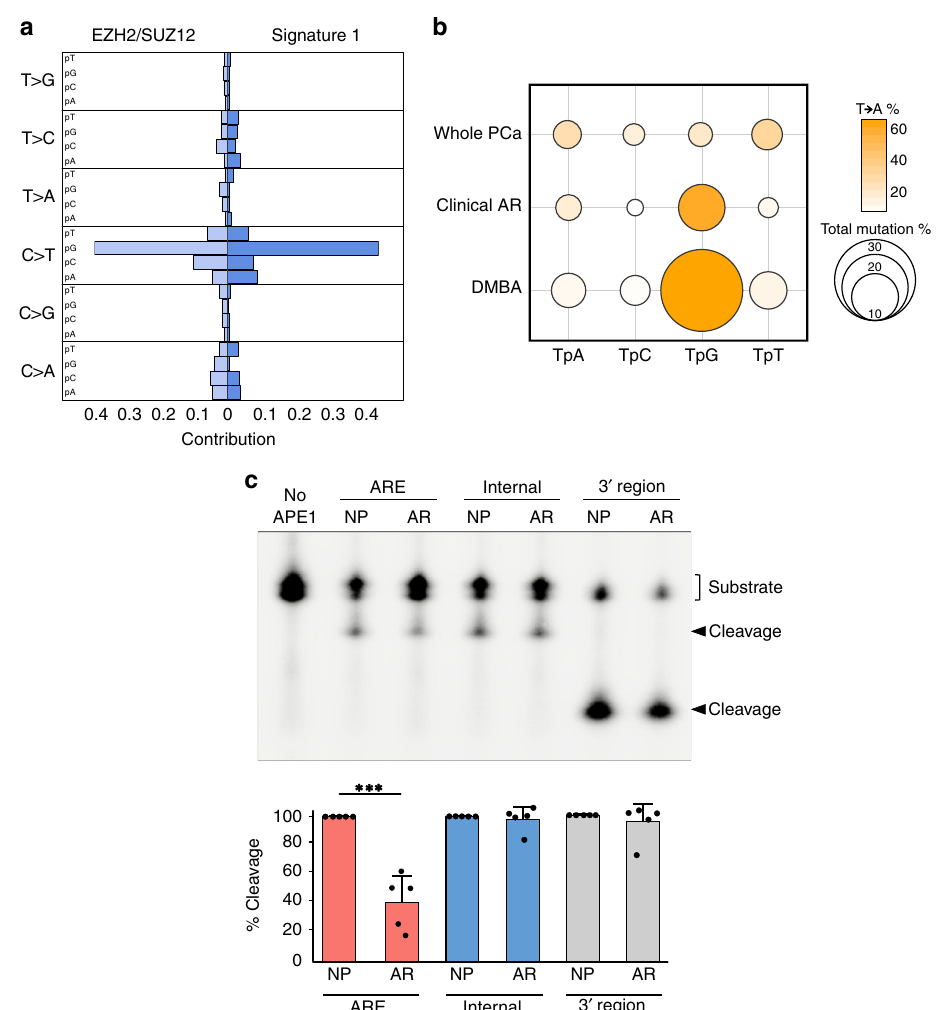
Fig. 4 Mutation at PRC2-binding sites and ARBS are similar to previously published work. a EZH12 and SUZ12 mutations were concatenated into a PRC2 signature and compared with COSMIC signature 1. b The frequency and nucleotide composition of T- > A transversions were compared between the whole PCa, clinical ARBS, and DMBA-treated mice. The majority of the T- > A mutation in both ARBS- and DMBA-treated mice were found to occur at TpG dinucleotides. c AR-DBD when bound to abasic DNA reduces APE1 cleavage. Radiolabled duplex DNA with an abasic site at the ARE (ARE), adjacent to the binding site (Internal) and removed from binding site (3 ’ region) were incubated with either no protein (NP) or AR-DBD (AR) and APE1. Cleavage of the product was quanti fi ed and then normalized to the no AR-DBD ( n = 5, mean ± SD, *** p <